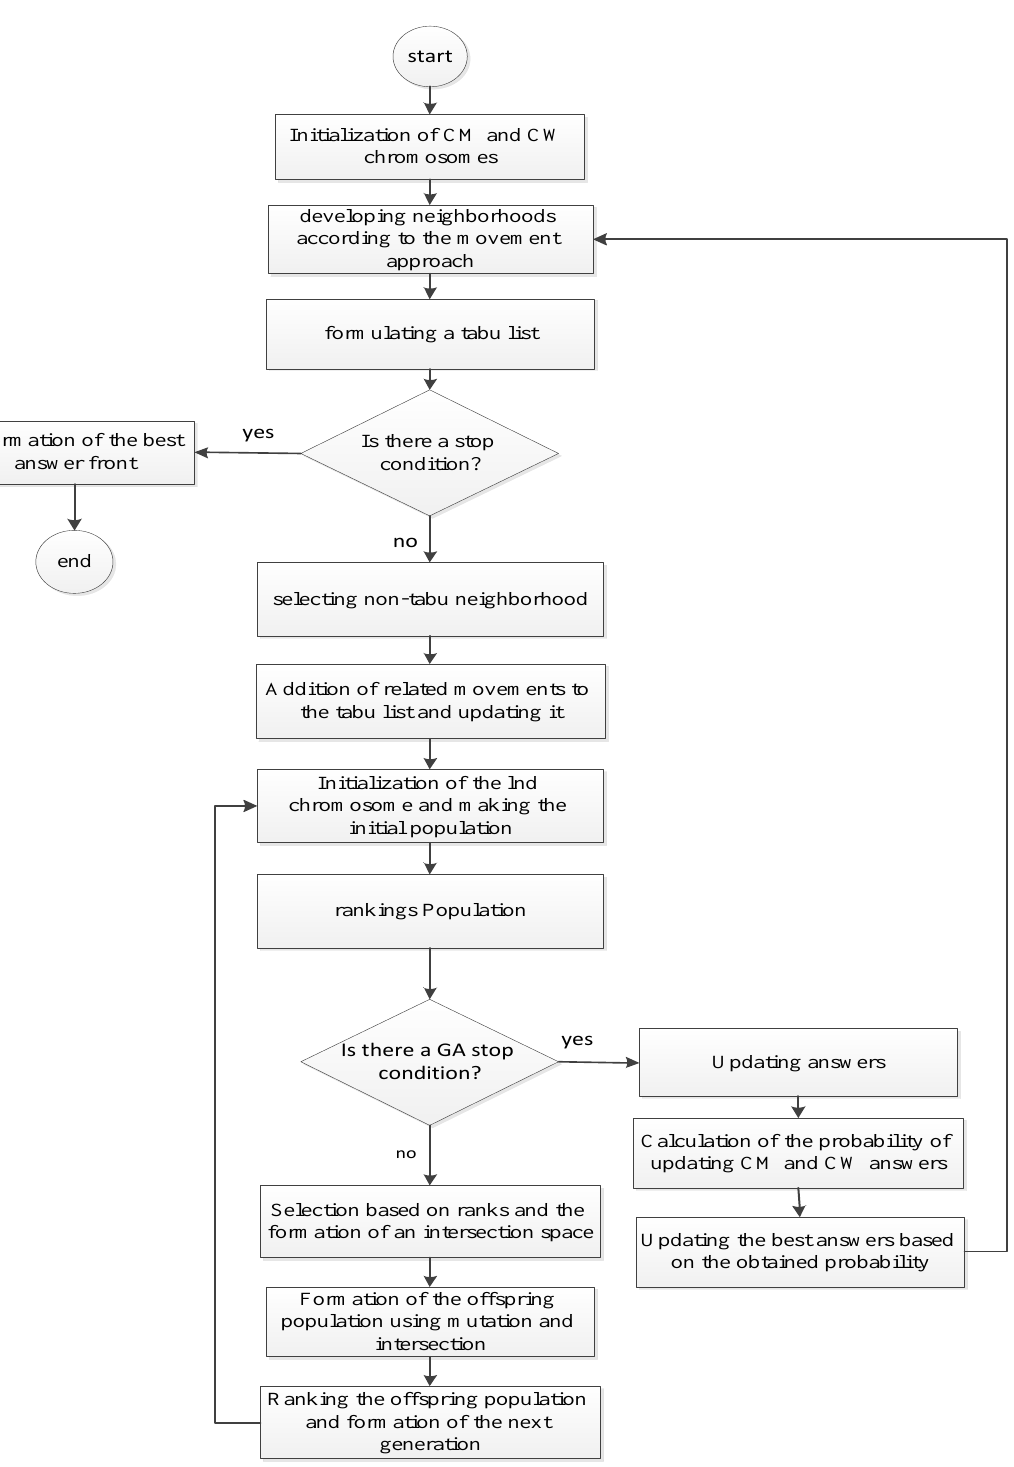
Fig. 1. Flowchart of MO-TS-GA hybrid algorithm.